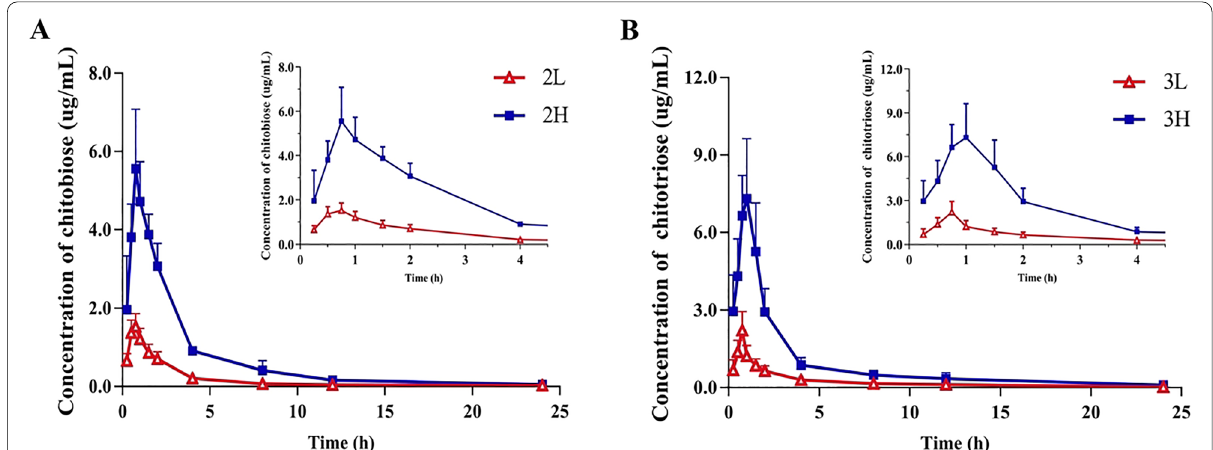
Fig. 2 Pharmacokinetic profile of COS 2 ( A ) and COS 3 ( B ) concentration (μg /mL) in rat serum ( n kg intragastric administration (2L: 100 mg/kg of COS 2; 2H: 500 mg/kg of COS 2; 3L: 100 mg/kg of COS 3; 3H: 500 mg/kg of COS 3;